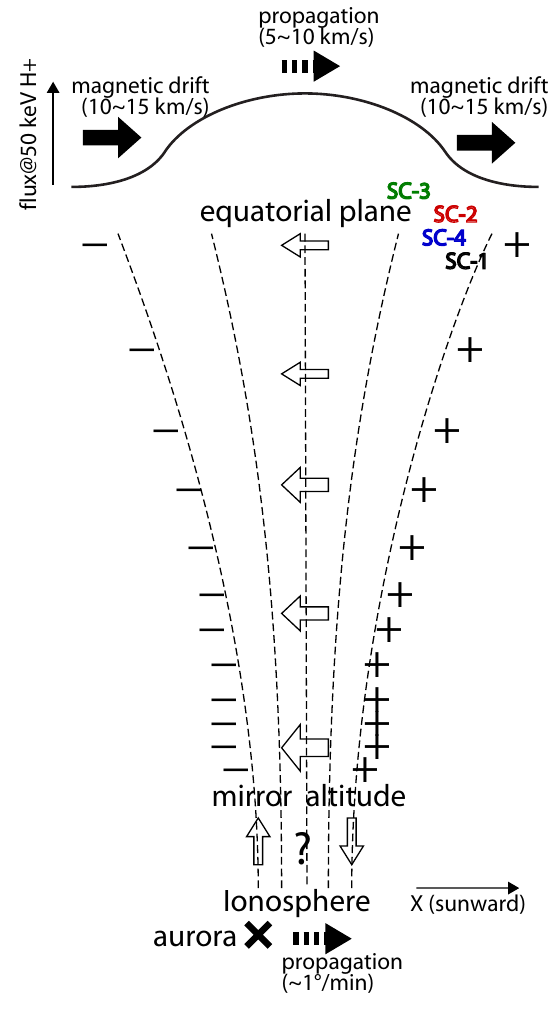
Fig. 12. Schematic illustration of the amplitude of the structure (flux of 3000km/s ions, strength of electric field, and depletion of the magnetic field) at the top, expected charges (+ and − ) along the geomagnetic field (dashed line) and resultant expected electric field (empty arrows) in the middle, and the expected auroral po- sition (cross) at the bottom. The observed propagation velocities (thick dashed arrows) matches between the structure in the magne- tosphere and the aurora in the ionosphere. The magnetic (summa- tion of gradient-B and curvature) drift of the 3000km/s protons is shown by thick arrows. The E × B drift (30 ∼ 50km/s duskward in the magnetosphere) is not illustrated.